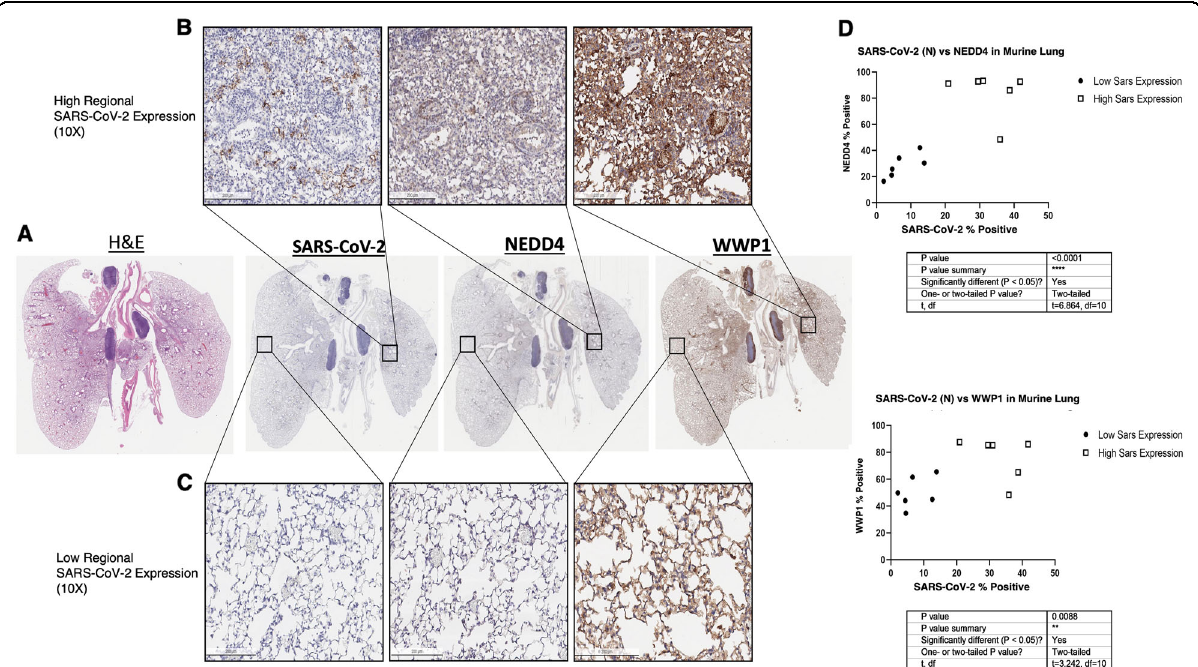
Fig. 3 Mouse lungs ( n = 3) expressing higher SARS-CoV-2 nucleocapsid protein express signi fi cantly higher NEDD4 ( p < 0.0001*****) and WWP1 ( p < 0.01**) in consecutive sections. Mouse lungs ( n = 3) expressing higher SARS-CoV-2 nucleocapsid protein express signi fi cantly higher NEDD4 ( p < 0.0001*****) and WWP1 ( p < 0.01**) in consecutive sections (10X mag). Regions qualitatively de fi ned as having high (>20% positive cells) Sars-CoV-2 expression (top row) and low (<20% positive cells) SARS-CoV-2 expression (bottom row), show with the corresponding regions in WWP1 and NEDD4 stained